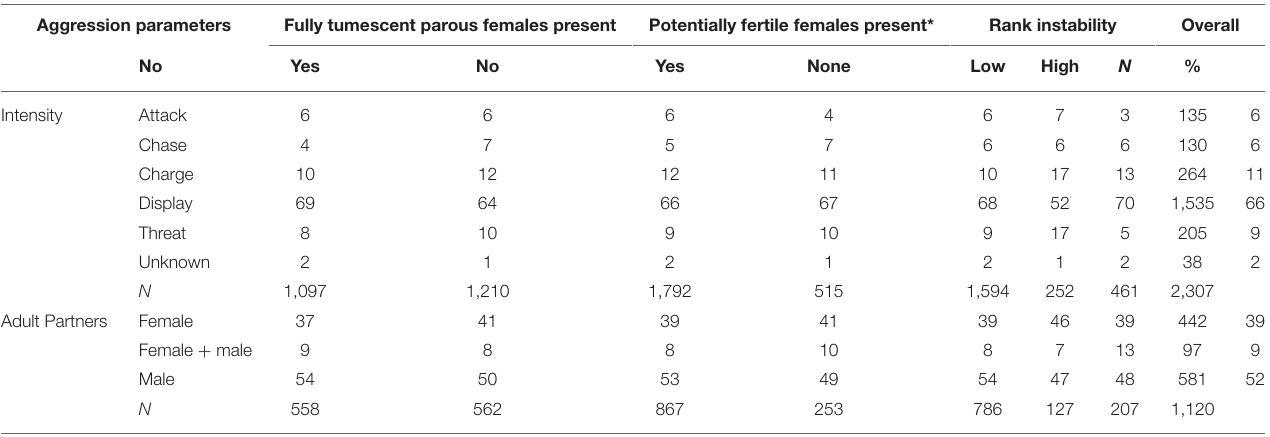
TABLE 2 | Intensities of all aggressions observed for focal males during the data collection period ( N = 2307), and sex of opponents for a subset of aggressions between adults ( N = 1120), presented in relation to the presence and absence of fully tumescent parous and potentially fertile females, and rank instability. Aggression parameters Fully tumescent parous females